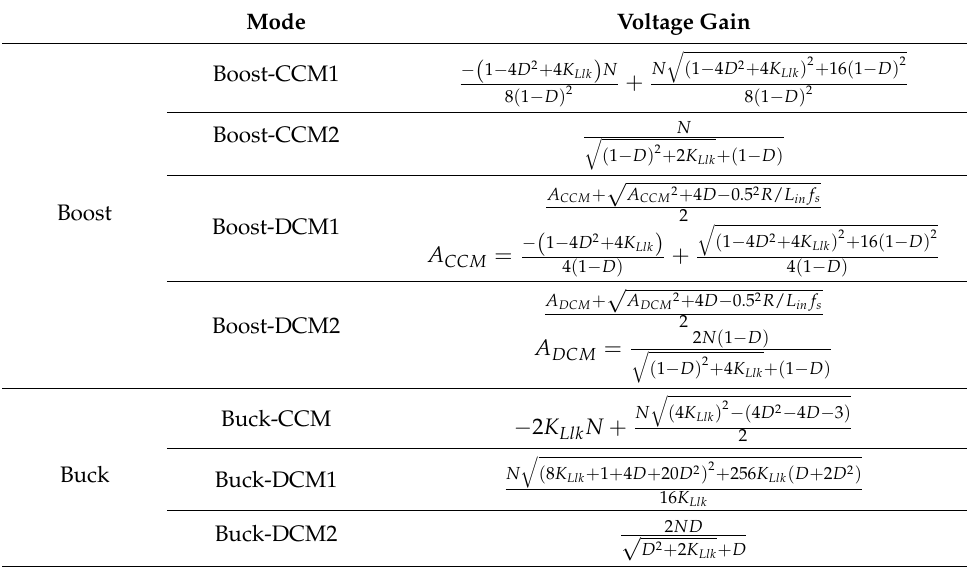
Table 1. Voltage gain in boost and buck